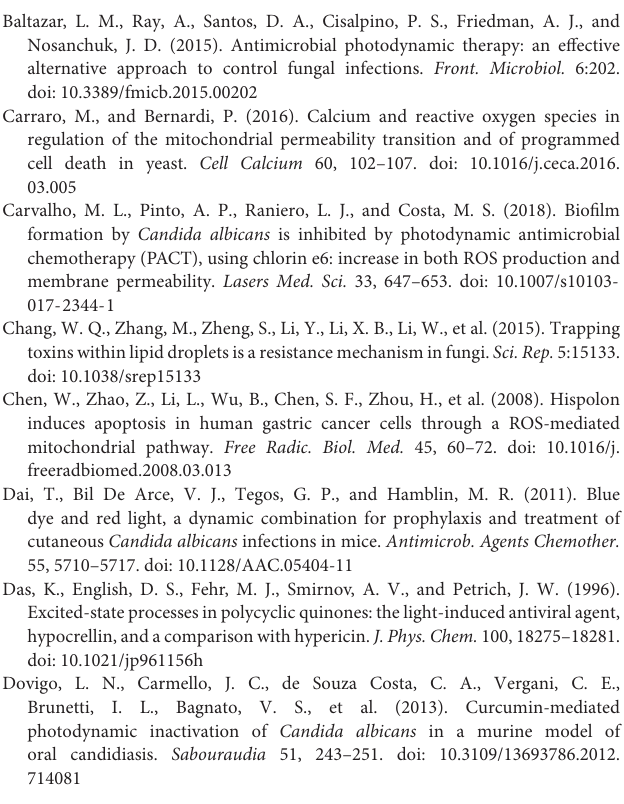
FIGURE S7 | DNA fragmentation in ATCC18804 and 07318 strains was analyzed by flow cytometry using TUNEL staining. The histogram showed the percentage of TUNEL-positive cells, and the values were expressed as mean ± SD. ∗ P < 0.05. FIGURE S8 | Nuclear condensation in ATCC18804 and 07318 strains was visualized with a fluorescence microscope using Hoechst33342/PI co-staining. Scale bars = 5 µ m. FIGURE S9 | Effect of HA on cytosolic calcium contents were examined by flow cytometry via Fluo-3 AM staining in ATCC18804 and 07318 strains. The percentage of Fluo-3 AM-positive cells were shown in the histogram, and data were shown as mean ± SD. ∗∗ P < 0.01. FIGURE S10 | Mitochondrial calcium level in ATCC18804 and 07318 strains was evaluated using Rhod-2 AM staining. The histogram was the quantitative analysis of the percentage of Rhod-2 AM-positive cells, and the data were expressed as mean ± SD. ∗ P < 0.05. FIGURE S11 | Effect of light-only treatment on the growth of C. albicans . ∗ P < 0.05 and ∗∗ P < 0.01. FIGURE S12 | The structure and UV-Vis absorption spectrum of HA. FIGURE S13 | Effect of HA and fluconazole (FLC) on C. albicans growth. ∗ P < 0.05, ∗∗ P < 0.01, and ∗∗∗ P < 0.001. FIGURE S14 | Effect of HA treatment on colony-forming units without adjusting to the same number. ∗ P < 0.05. FIGURE S15 | Effect of ROS scavengers and quenchers on the photodynamic inactivation of C. albicans by HA. ∗ P < 0.05 and ∗∗ P <